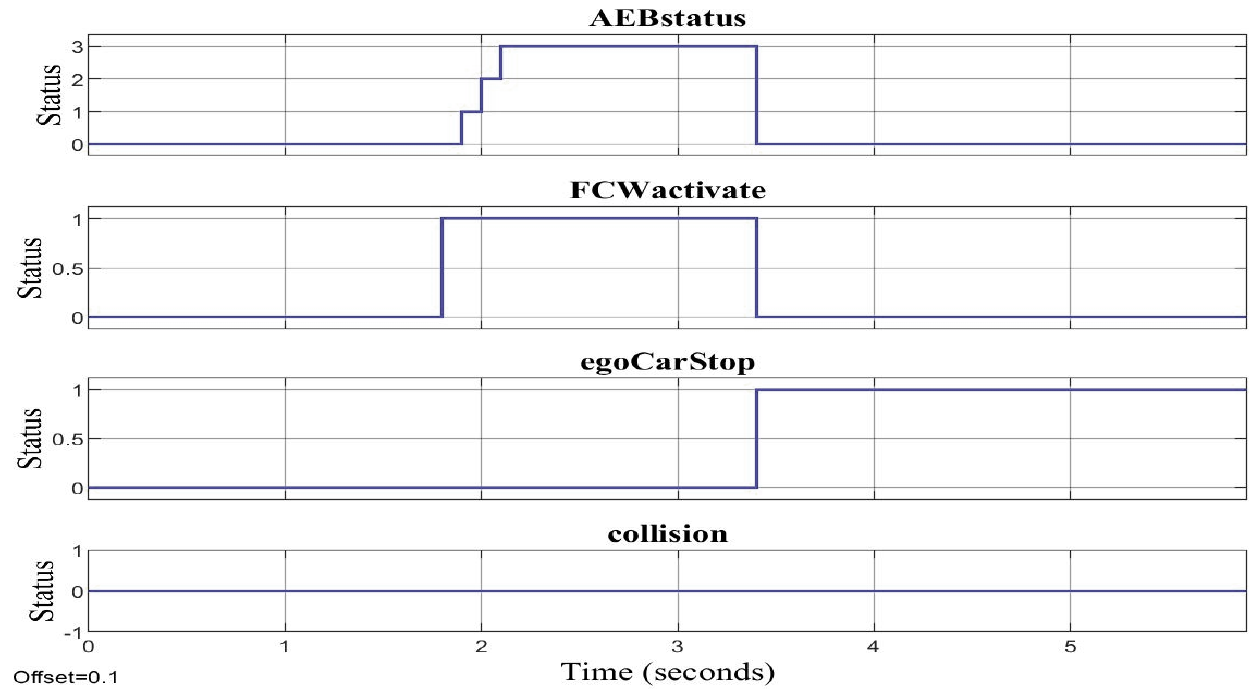
Figure 18. Status of AEBS, FCW, ego car stop, and collision at high speed.